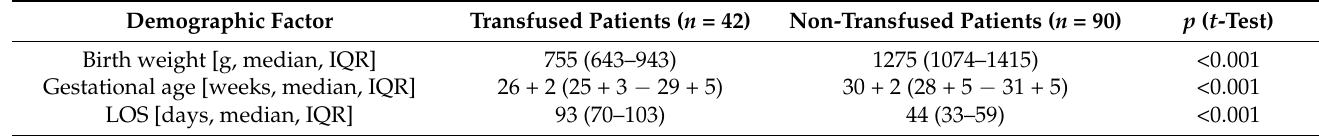
Table 2. Demographic differences between transfused and non-transfused